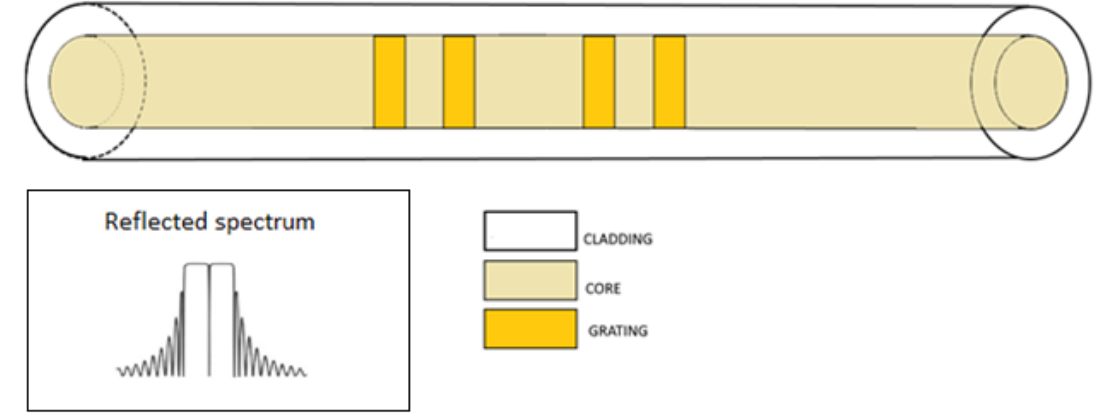
Figure 8. Phase shifted FBG. Inset: reflected spectrum.